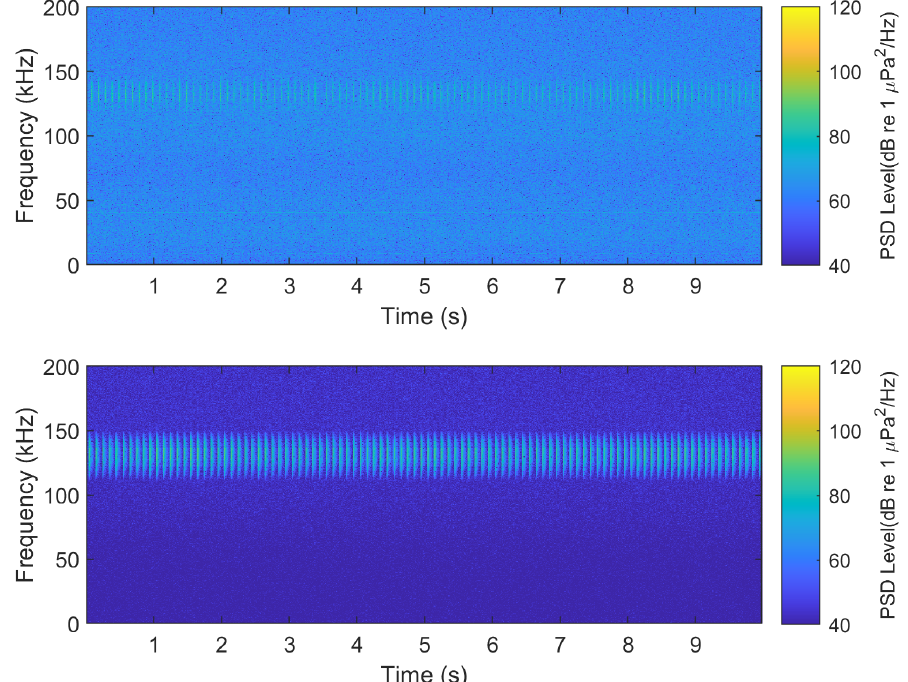
Figure 11. Spectrogram of the PorpDAQ ( top ) and the reference system ( bottom ) of a simulated click recorded by both